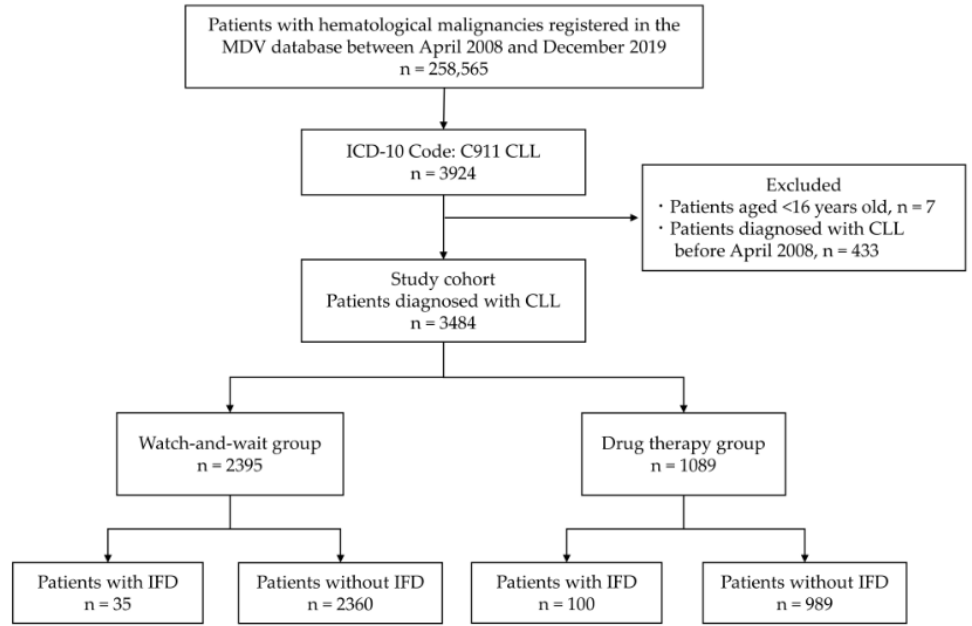
Figure 1. Patient selection flow diagram. Abbreviations: MDV, Medical Data Vision; CLL, chronic lymphocytic leukemia; IFD, invasive fungal disease; ICD-10, International Classification of Diseases 10th